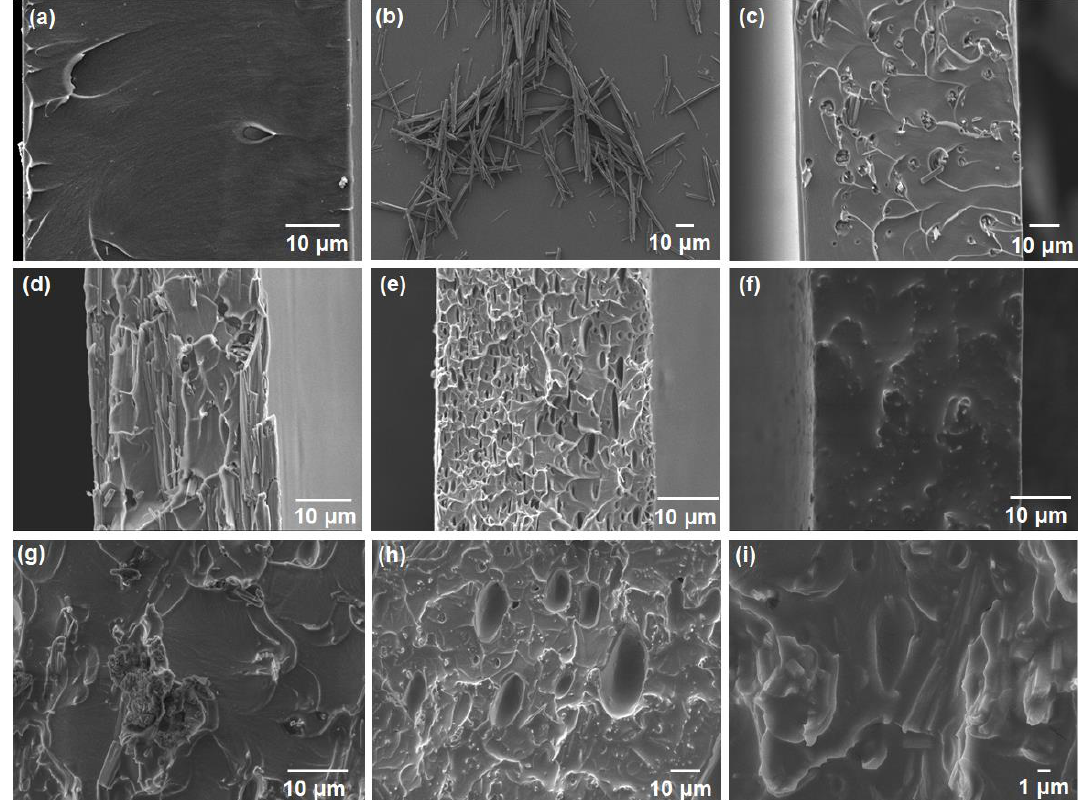
Figure 4. Cross-sectional FESEM images of ( a ) pure Matrimid membrane; ( b ) CoPCMP (deposited